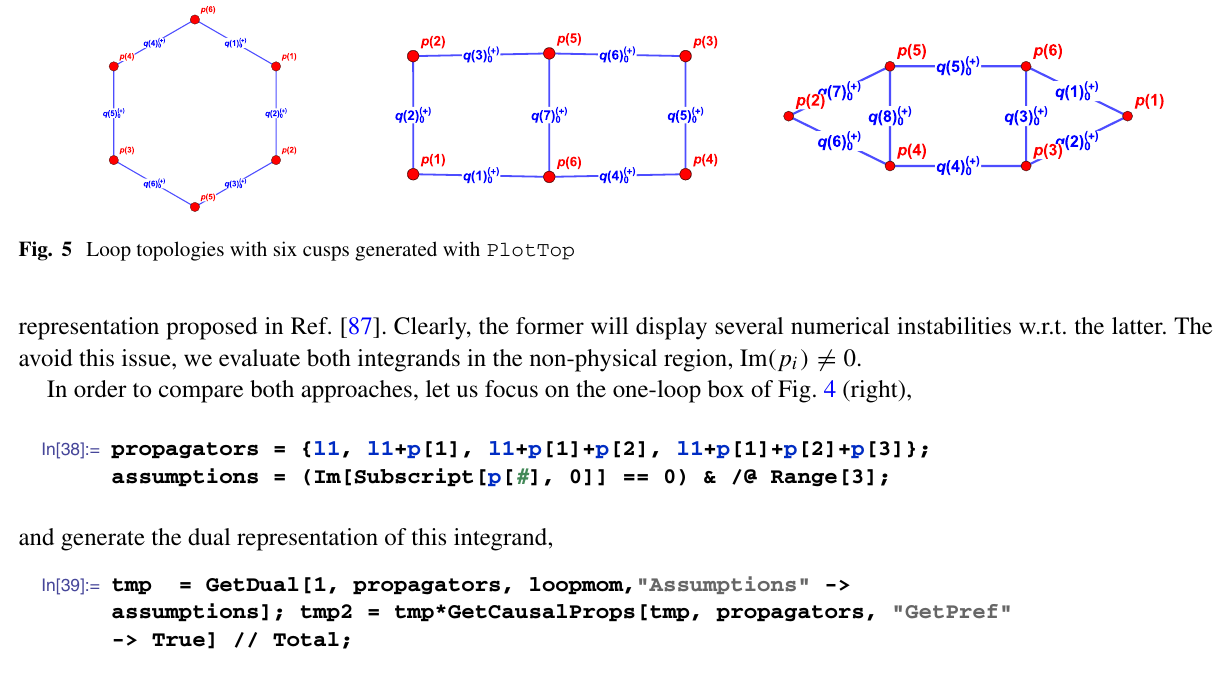
Fig. 5 Loop topologies with six cusps generated with PlotTop